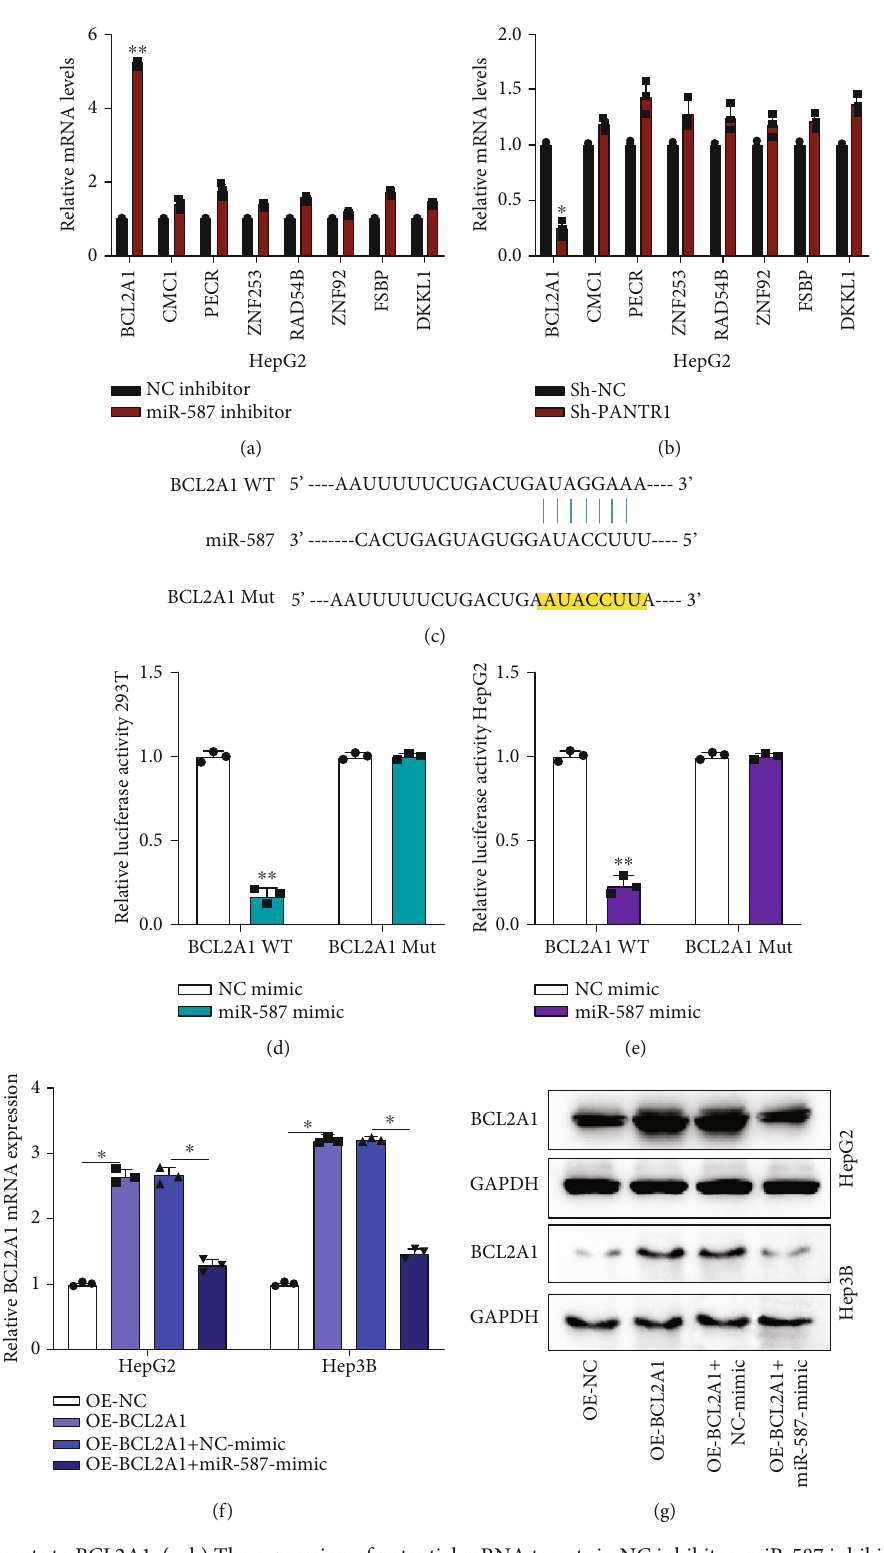
Figure 5: MiR-587 targets to BCL2A1. (a, b) The expression of potential mRNA targets in NC inhibitor, miR-587 inhibitor, Sh-NC, and Sh- PANTR1-transfected HepG2 were measured by qRT-PCR. (c) The binding sites between BCL2A1 and miR-587 are shown. (d, e) Luciferase activities in HepG2 and Hep3B pretransfected with NC mimic, miR-587 mimic, and reporter vectors containing BCL2A1 WT or Mut sequences were detected and analyzed. (f, g) The mRNA and protein expression of BCA2A1 in OE-NC-, OE-BCL2A1-, OE-BCL2A1+NC- mimic-, and OE-BCL2A1+miR-587-mimic-transfected HepG2 and Hep3B cells were detected by qRT-PCR and western blot assays. Data are shown as the mean ± standard deviation ( n = 3 ). ∗ P < 0 : 05 and ∗∗ P < 0 : 01